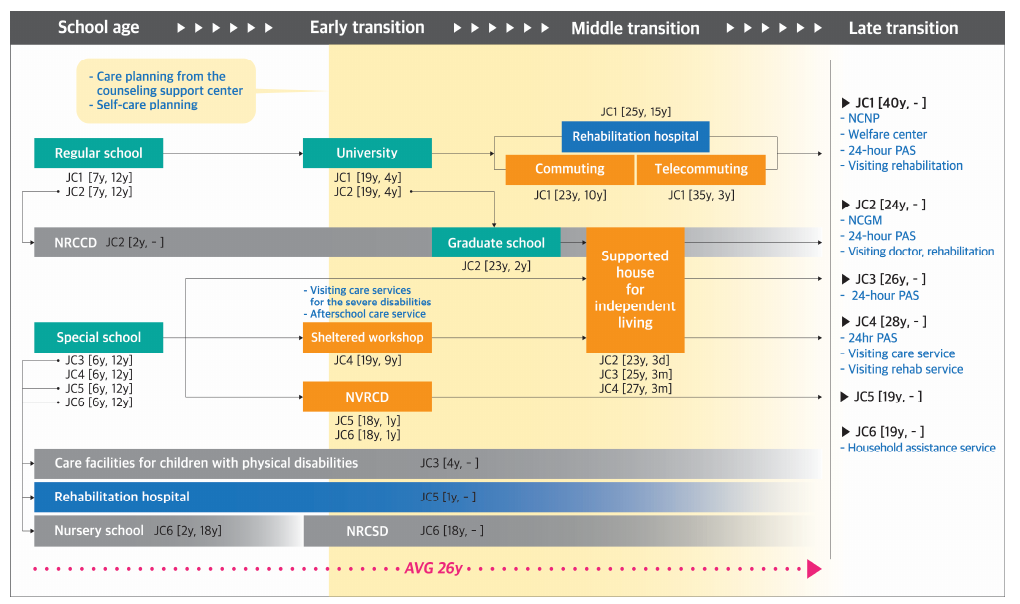
Figure 1. Pathway mapping for Japanese individuals with congenital disability. NRCCD, National